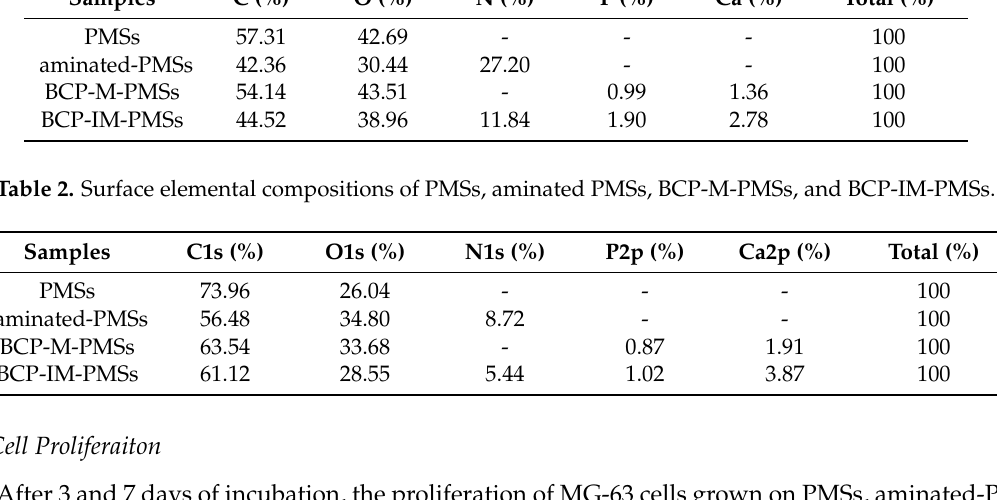
Table 1. Elemental compositions of PMSs, aminated PMSs, BCP-M-PMSs, and BCP-IM-PMSs. Samples